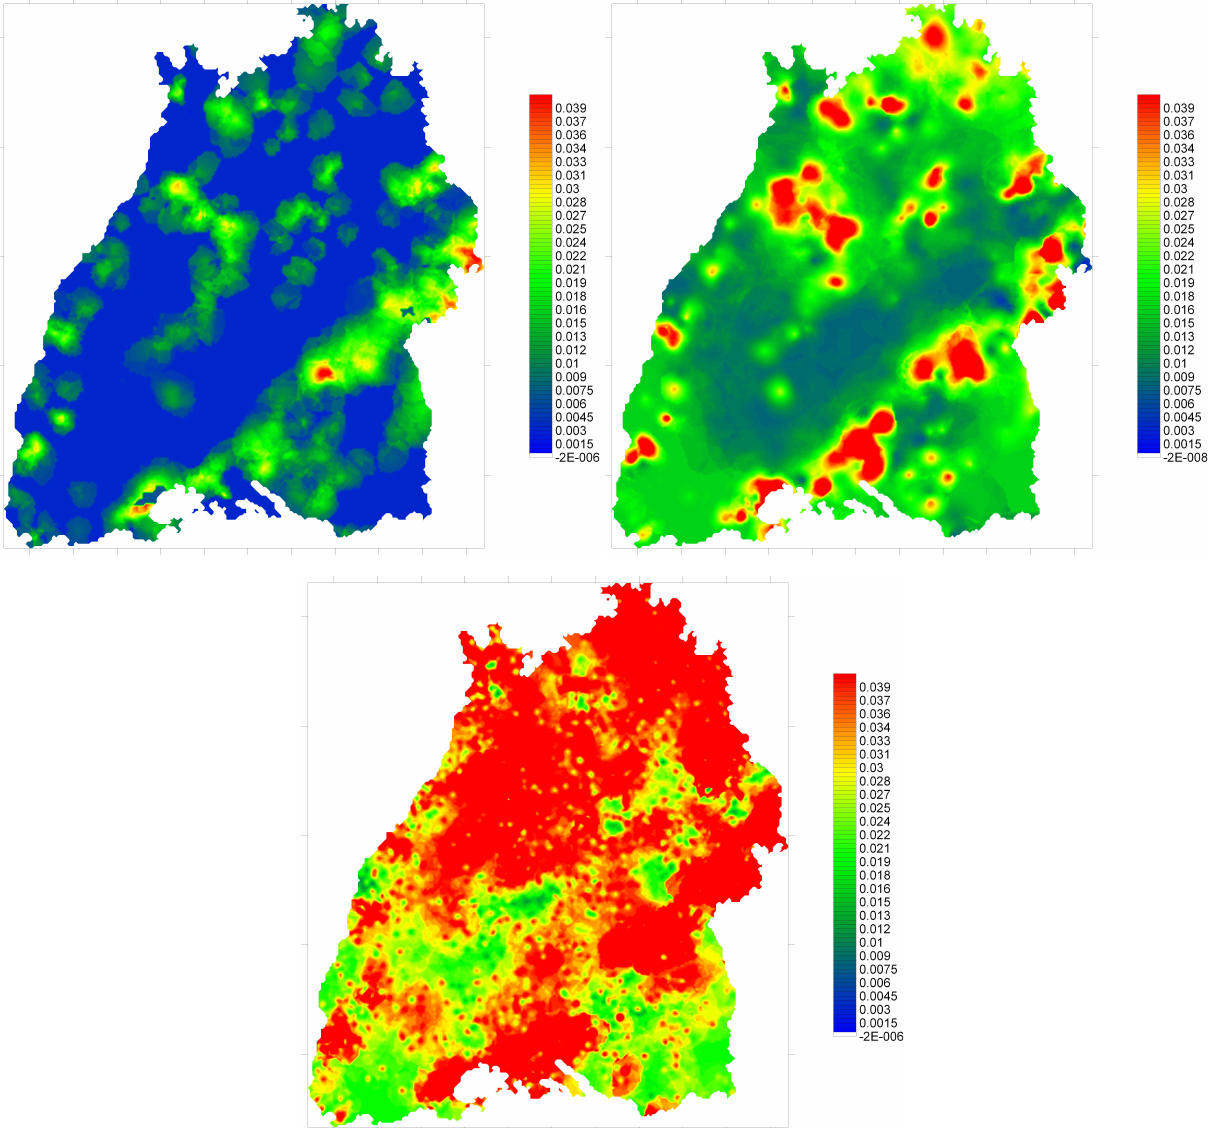
Fig. 8. Interpolated deethylatrazine concentrations using different interpolation methods. For OK the values were set to the detection limit.